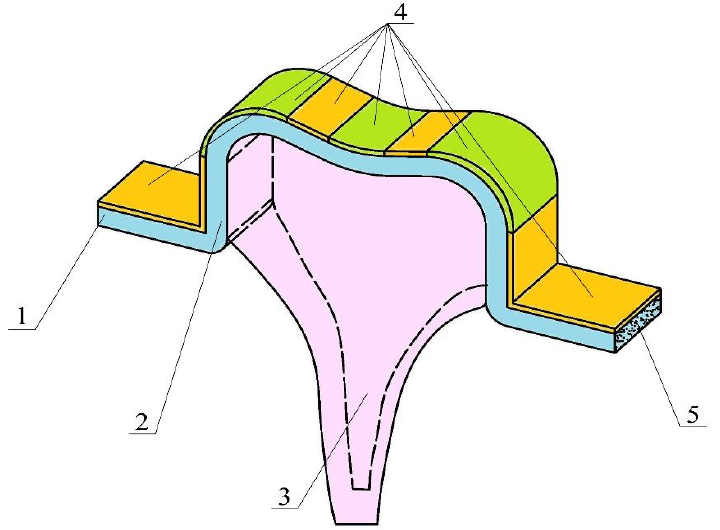
Figure 2. Structural diagram of constrained flow passage for complex surface of artificial joint: 1, inlet; 2, constrained flow passage; 3, workpiece; 4, constrained module (seven segments); 5, outlet.